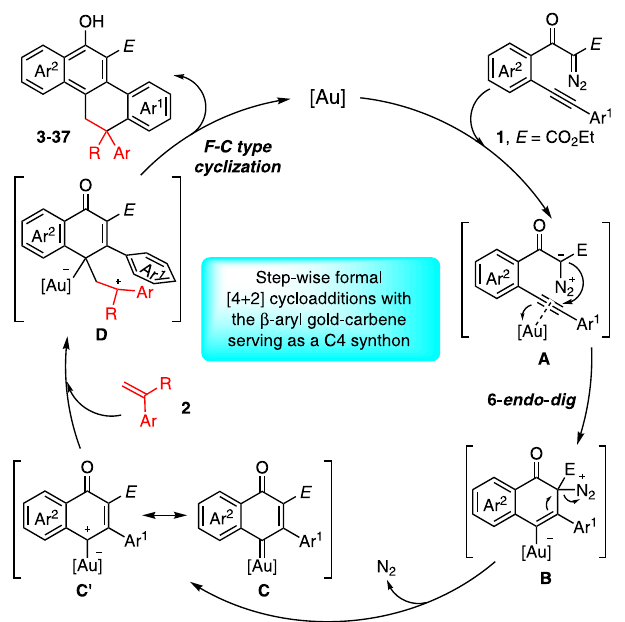
Fig. 8 Proposed reaction mechanism. The formal [4 + 2]-cycloaddition of in situ generated β -aryl gold-carbene intermediate with